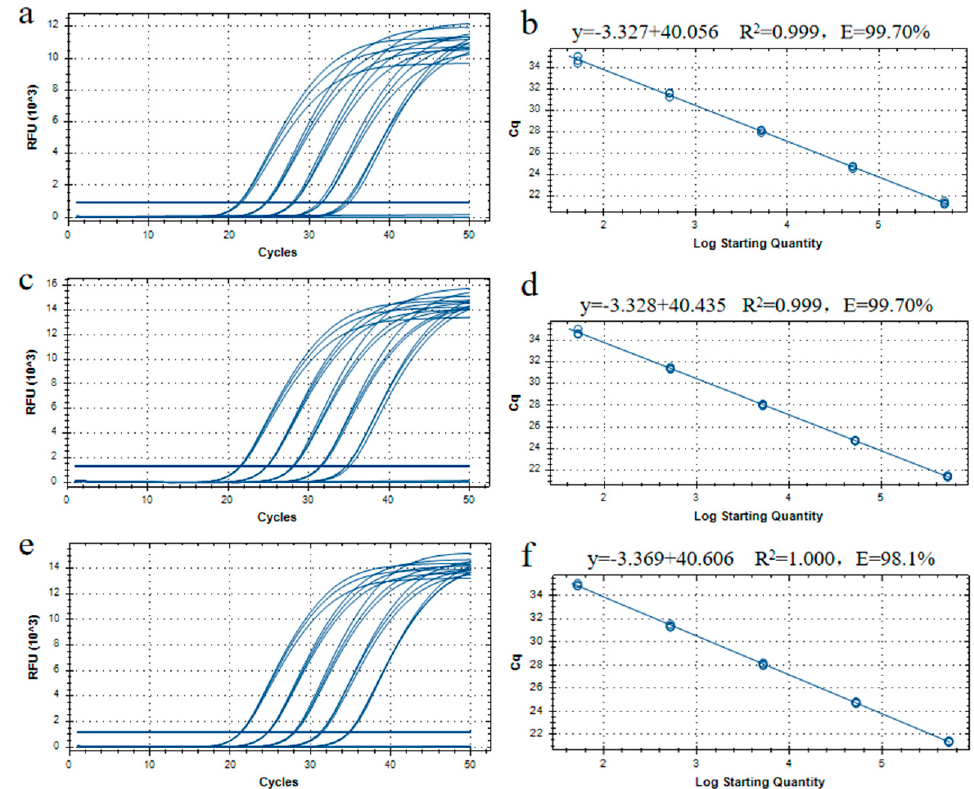
Figure 4. Amplification and standard curves for the quantitative PCR method using gradient-diluted pFP-hpt plasmid DNA as a template. ( a , c , e ): Amplification graph for the quantitative PCR assay